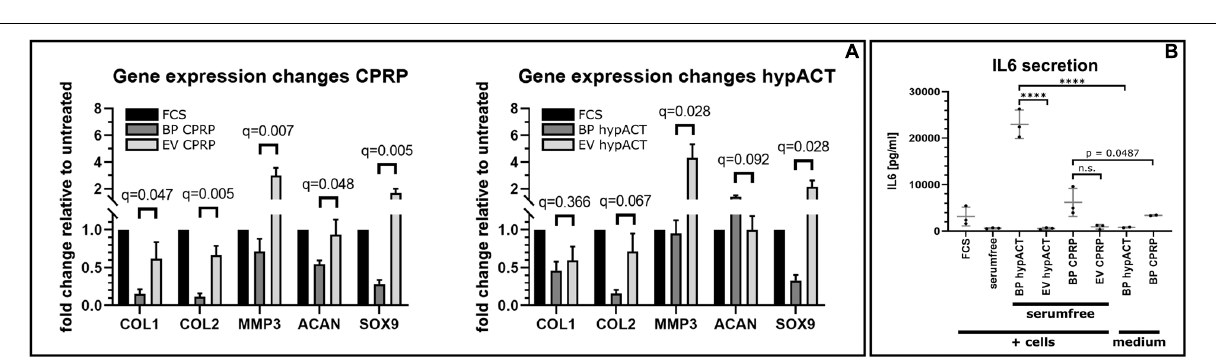
factor of 4.0 [ t (6) = 2.049; q = 0.047], 5.6 [ t (6) = 4.376; q =